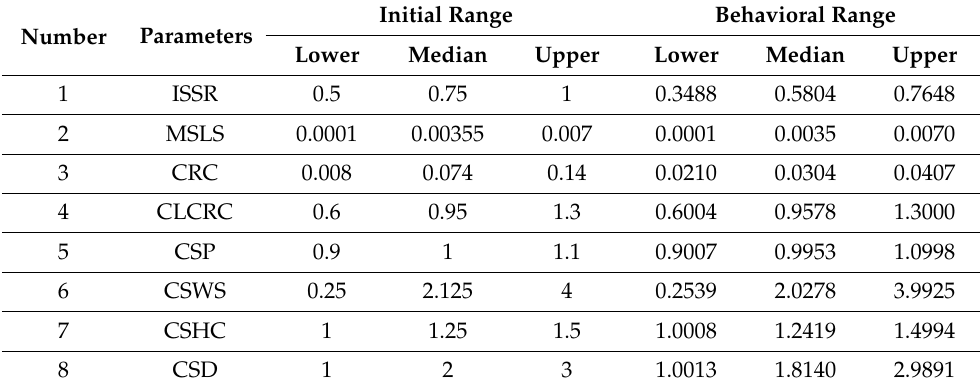
Figure 8. Distribution of L3 − based behavioral models by parameter ( a1 – a8 ) NSE results; ( b1 – b8 ) PBIAS results; ( c1 – c8 ) LOG results.